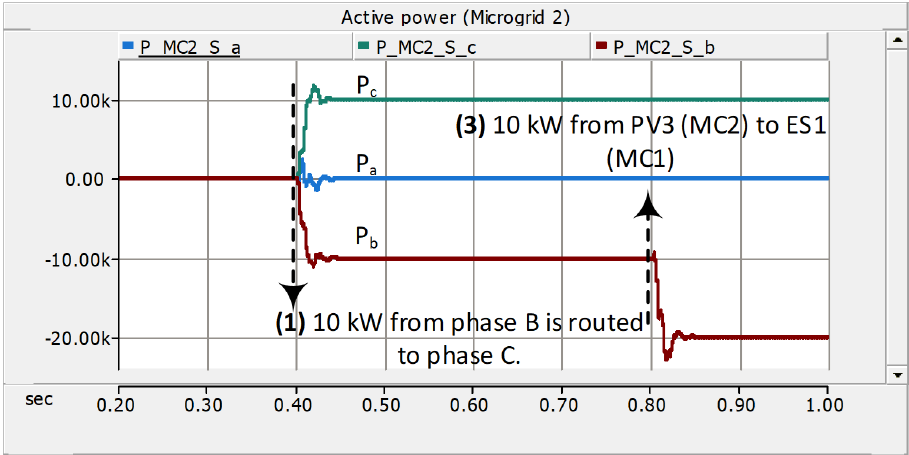
Figure 13. Active power at the wye side at the delta-wye transformer (Dy1) of MC2. Active power in phase A, B and C are labeled as P a , P b , P c ,